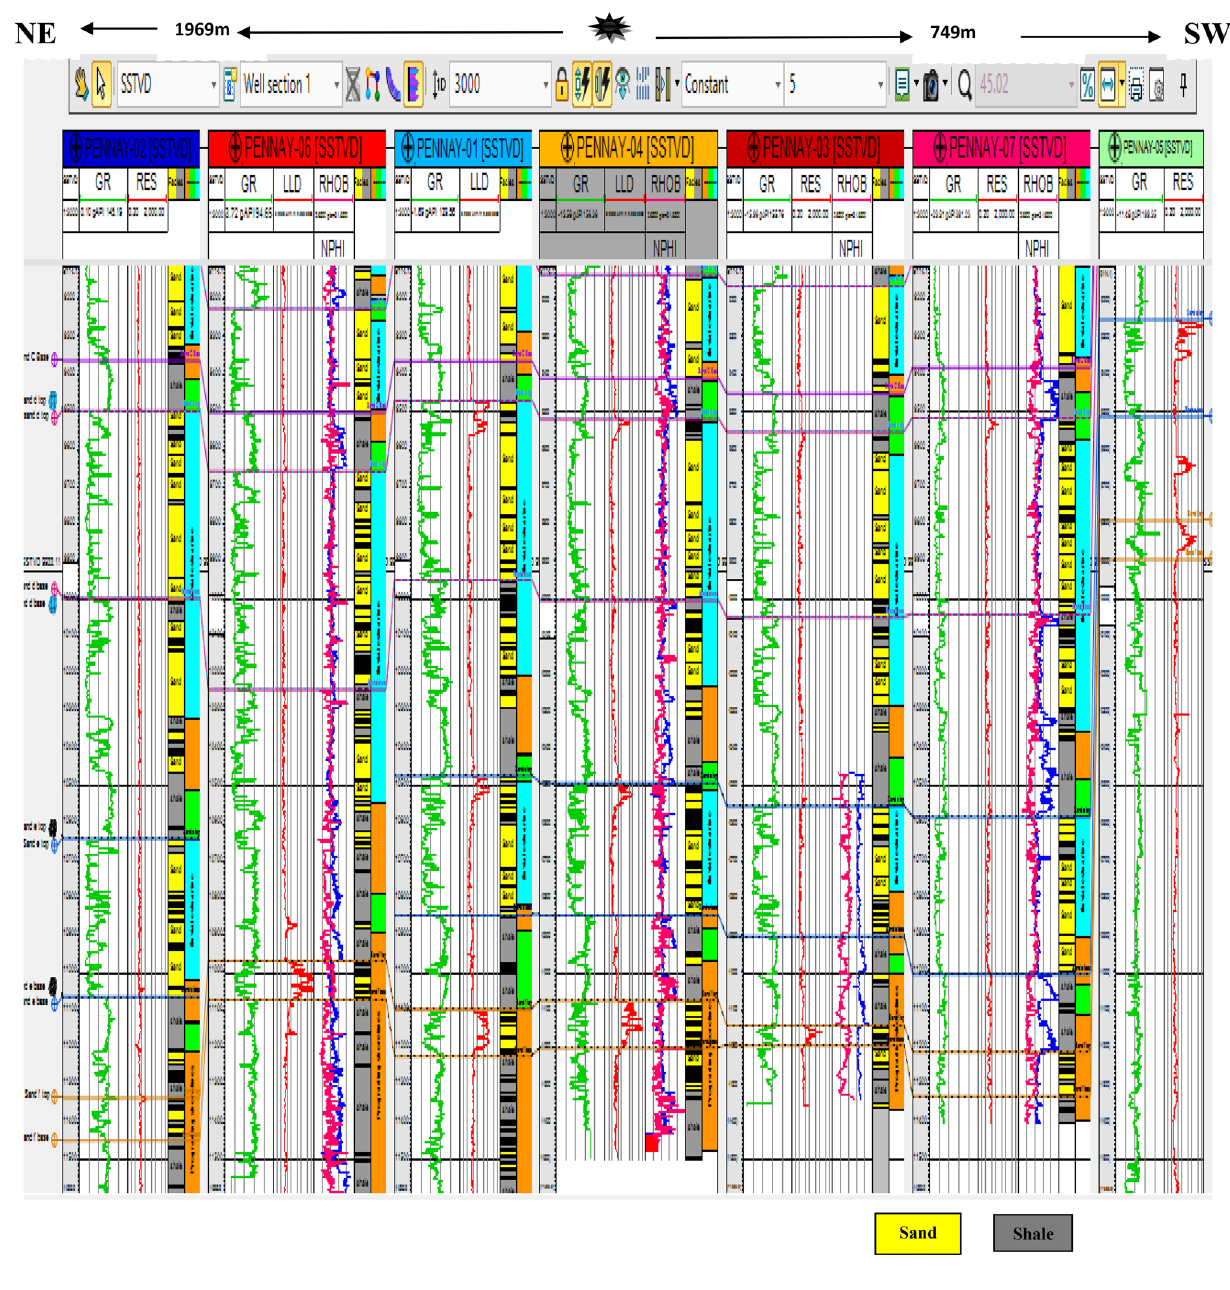
Fig. 6 Lithostratigraphic correlation section across the